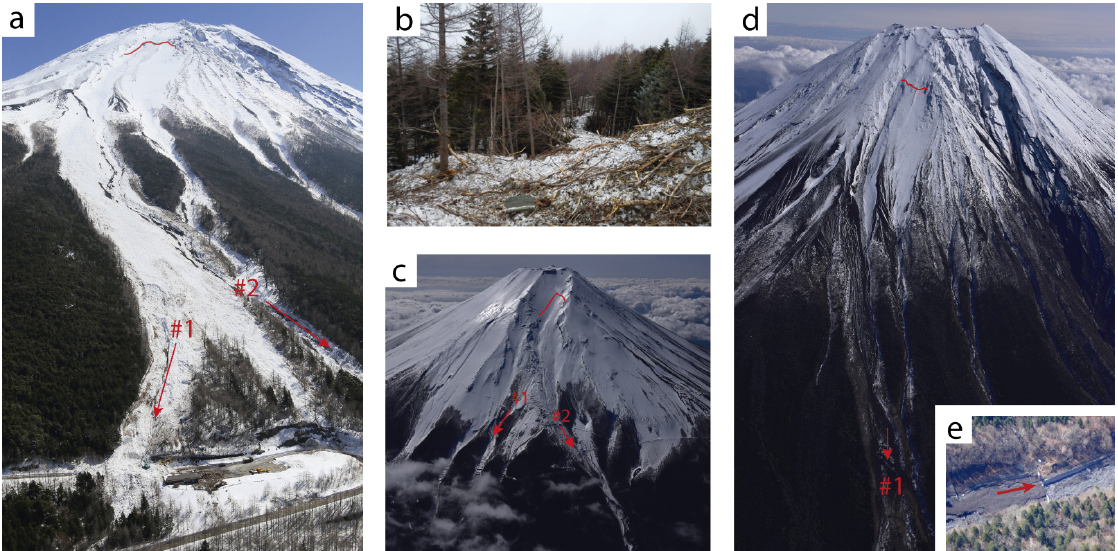
Figure 2. (a) Aerial photo of the snow avalanche #1 released on 13 March 2014 on the WNW flank (source: Asahi Shimbun Digital, https://www.asahi.com/, last access: 18 October 2019). The main flow impacted the road (path #1), and a secondary surge continued flowing downwards following path #2. (b) Photo of the deposits of avalanche #1 showing part of the forest damaged by the avalanche before the impact on the road (path #1). (c) Aerial photo of the large wet-snow avalanche #5 released on 14 February 2016 on the NE flank. The fracture of the slab was visually identified at a mean elevation of 3300m a.s.l., and the flow split into two branches, #1 and #2. (d) Aerial photo of the wet-snow avalanche #6 released on 14 February 2016 on the WNW flank. The fracture of the slab was identified at a mean elevation of 3200ma.s.l. The flow impacted the deflecting dam (#1), destroying some instruments. (e) Aerial picture of the deposits observed along the Osawa river at 1500ma.s.l. from slush flow #7 that released on the W flank on 5 March